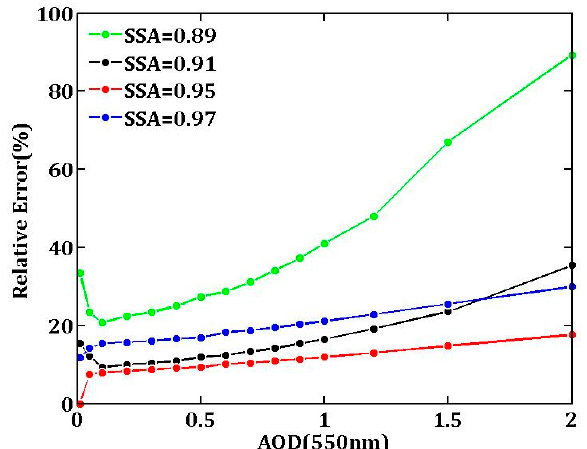
Figure 4. Sensitivity study on the single scattering albedo (SSA) ( θ s = 30°, θ v = 30, ϕ = 30). Table 2. Average SSA values during approximately 2010–2018.